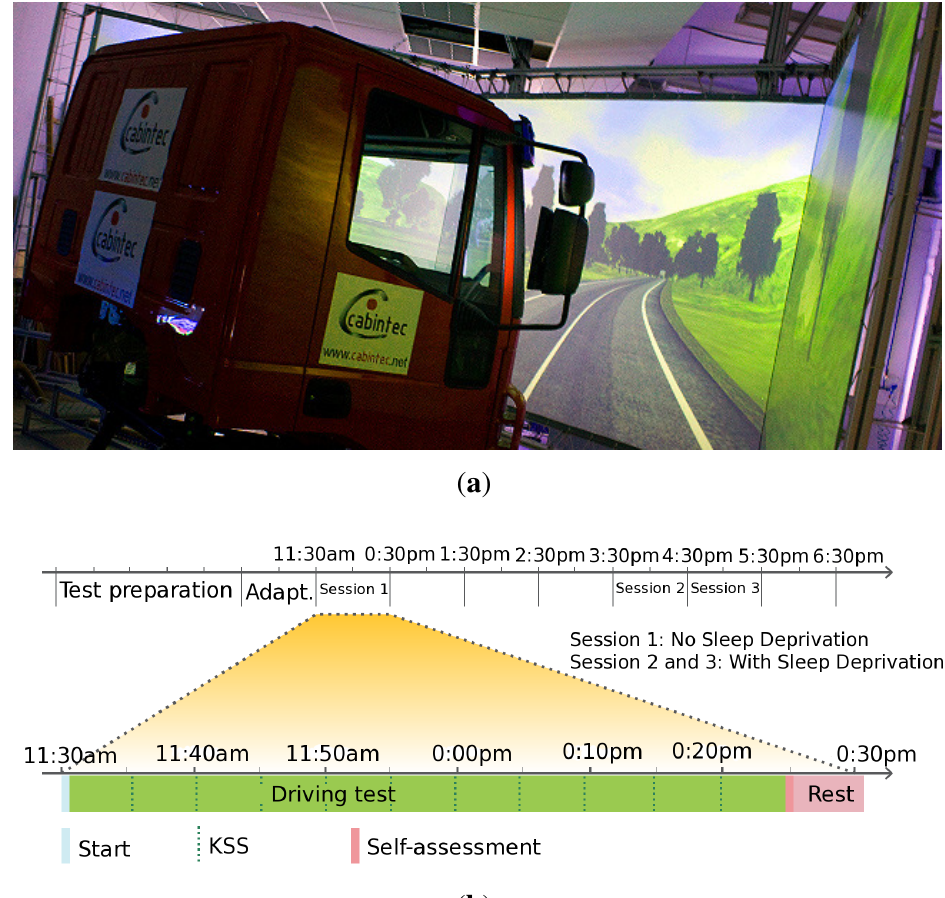
Figure 1. Simulation test design. ( a ) Simulation environment overview; ( b ) Driving sessions